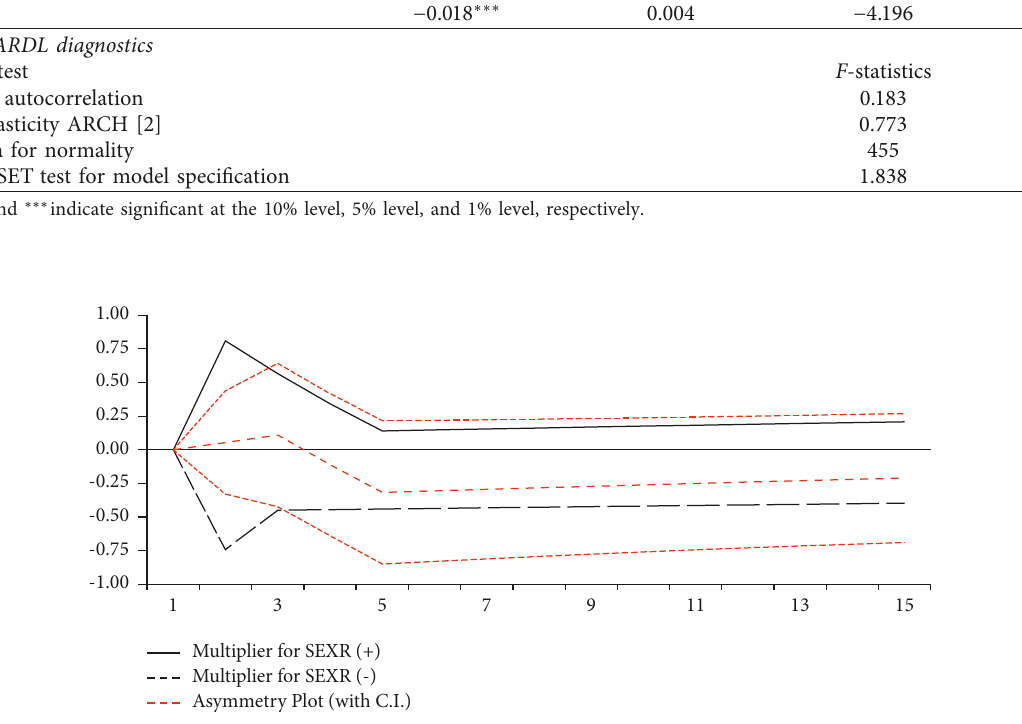
Figure 2: NARDL (1,4,2) dynamic asymmetric